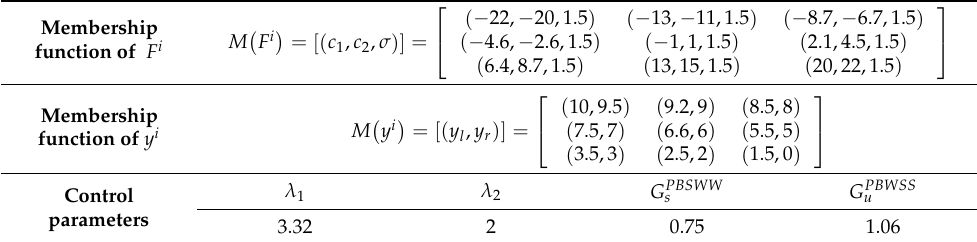
Table 5. The used parameters for the PBWSS with the IT2FSC for dynamic unloading force